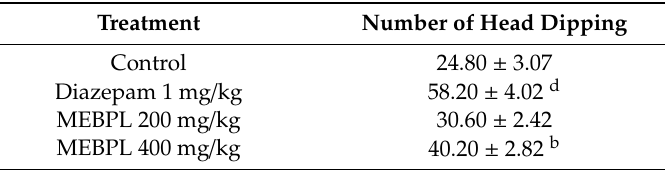
Table 4. Anxiolytic e ff ect of methanol extract of B. pilosa leaves (MEBPL) via hole-board test in mice.